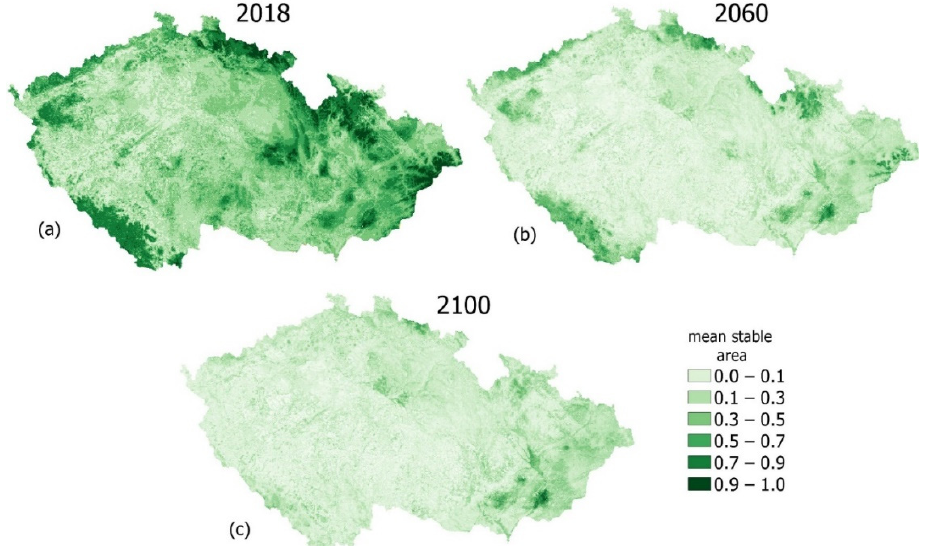
Figure 4. Variability in landscape vulnerability, captured as the mean stable area index (MSAi). ( a ) current (2018) situation, ( b ) 2060 and ( c ) 2100. All changes are with reference to the baseline period (1990). Future changes are based on the RCP 8.5 climate scenario.